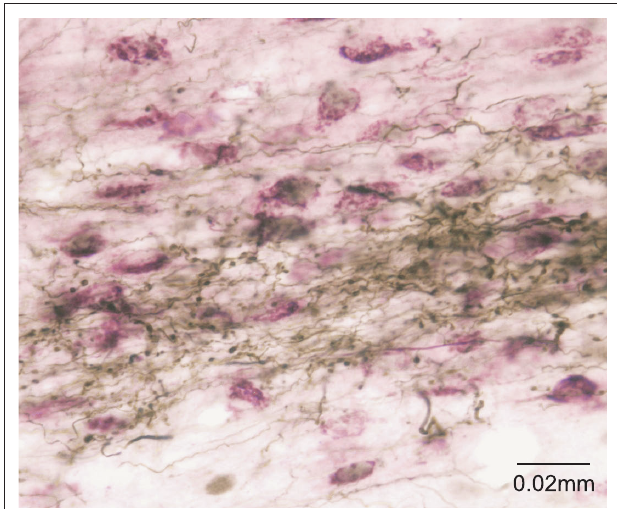
Figure 2 | The tecto-thalamo-striatal projection. Thalamo-striatal neurones in the central medial nucleus of the thalamus labeled with CTb (purple) retrogradely transported from the striatum, surrounded by terminal boutons labeled with biotinylated dextran (brown) anterogradely transported from the deep layers of the superior